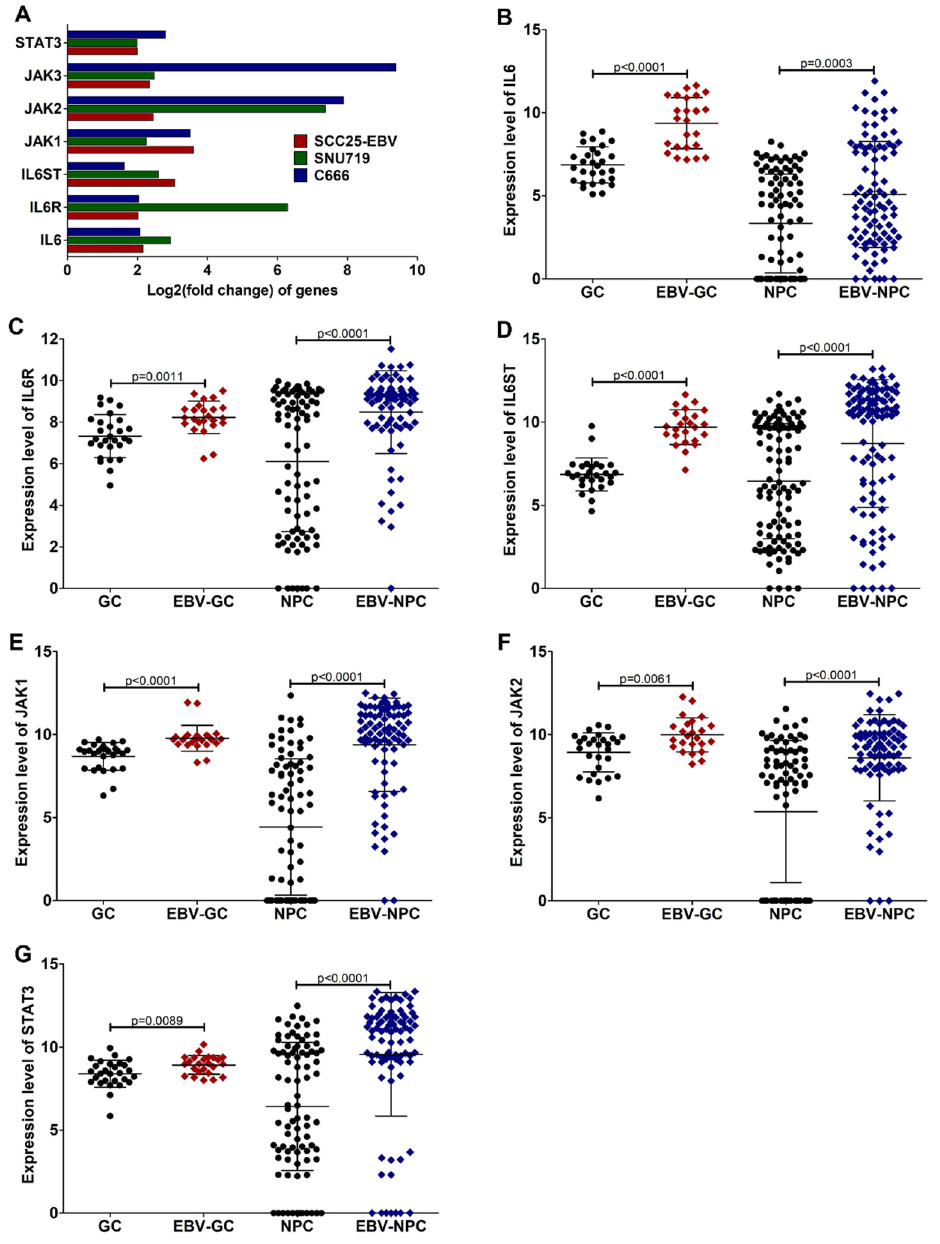
Figure 7. Key genes in the IL6/JAK/STAT3 signaling pathway are upregulated in EBV-associated epithelial cancers. The expression of key genes in the IL6/JAK/STAT3 signaling pathway was determined in EBV-infected cells ( A ). In the tumor tissues, the expression of IL6 ( B ), IL6R ( C ), IL6ST ( D ), JAK1 ( E ), JAK2 ( F ), and STAT3 ( G ) was also examined. In addition, the expression of key genes in the TNF- α /NF- κ B signaling, including NFKB1 (p50), RelA (p65), TNFRSF1A (TNFR1), TNFR1-associated death domain protein (TRADD), and TNF receptor-associated factor 2 (TRAF2), was examined in the cell lines and tumor tissues of EBV-associated cancers. As expected, the expression of key genes in the TNF- α /NF- κ B signaling was significantly upregulated in the EBV-positive cell lines (Figure 8A). The expression of these genes was also higher in EBV-positive tumor tissues than in EBV-negative tumor tissues (Figure 8B–F).